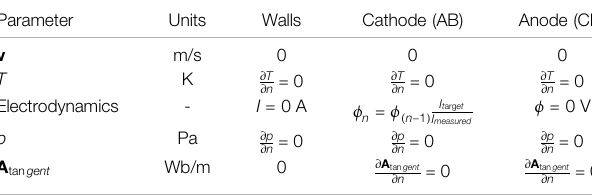
TABLE 1 | Boundary conditions for the model.